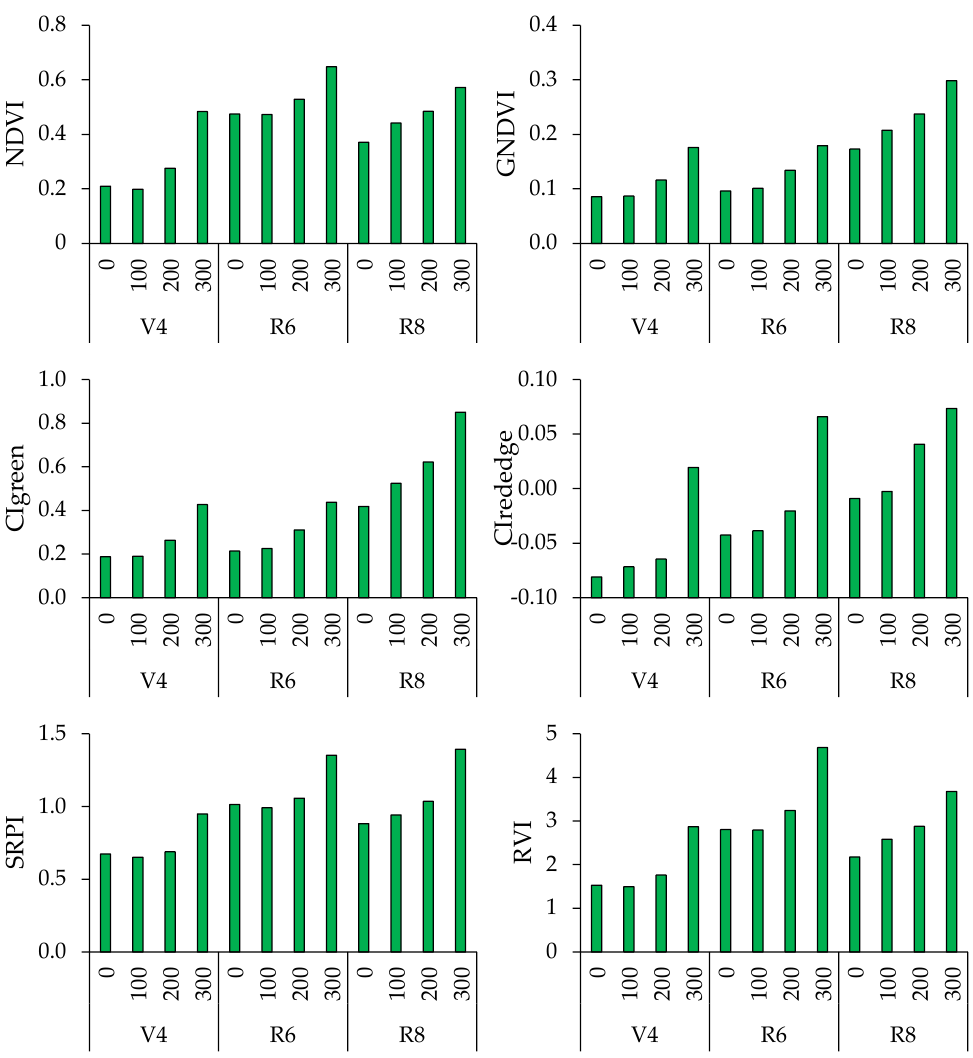
Figure 5. Vegetation indices by inoculant level (0, 100, 200, and 300 mL) for growth stages (V4, R6, and R8).